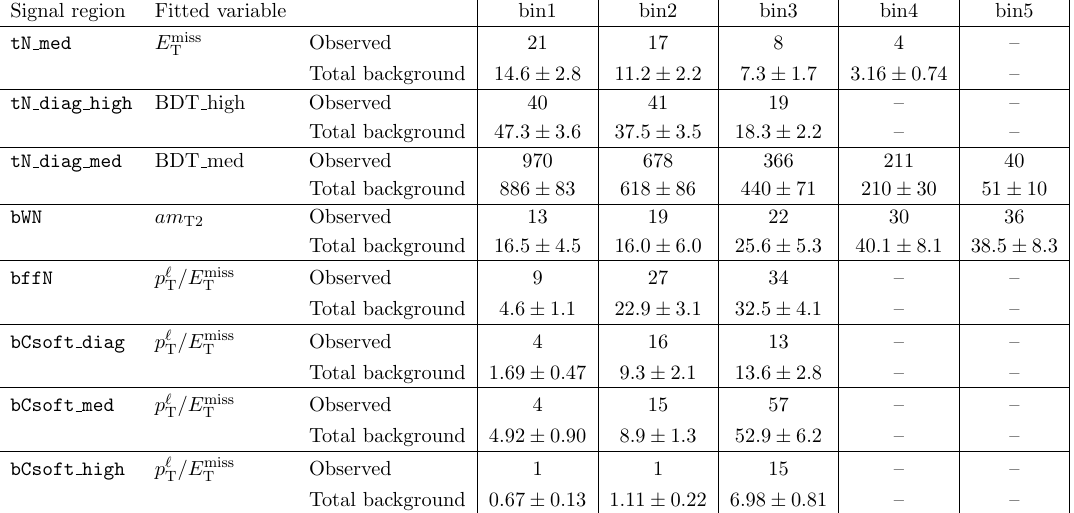
Table 25 . The numbers of observed events in each bin of the shape-(cid:12)t SRs together with the ex- pected numbers of total background events and their uncertainties as predicted by the background- only (cid:12)ts. The bin i ( i = 1{5) corresponds to the i -th bin (from left to right) of the variable used in the shape-(cid:12)t. The bin boundaries of the shape-(cid:12)ts are detailed in table 6, 7, 8, and